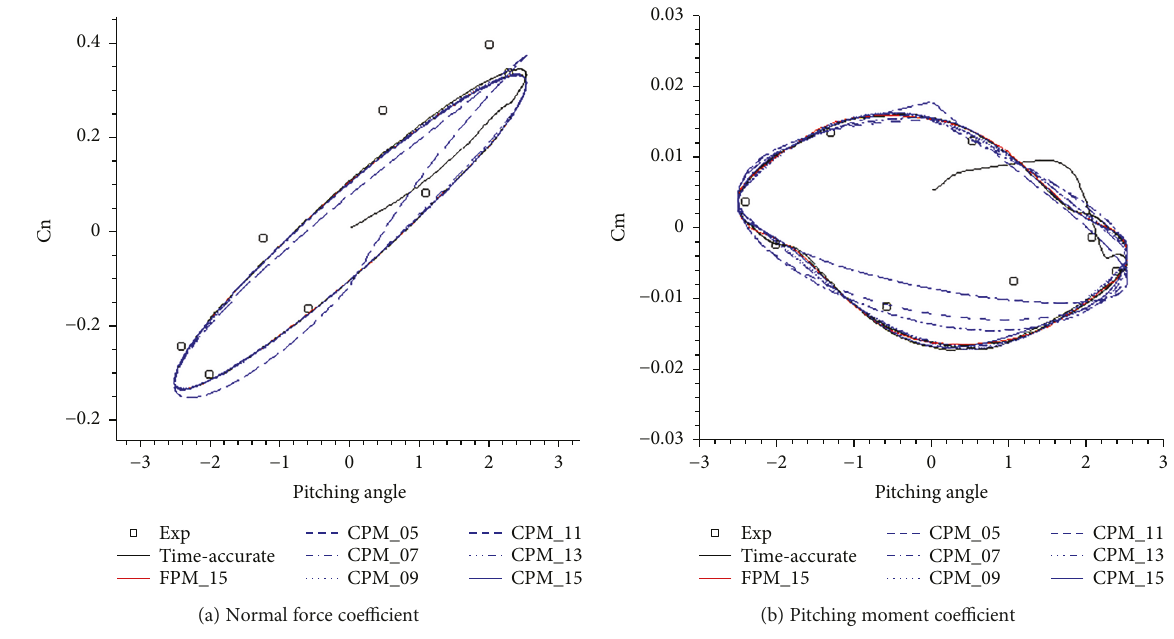
Figure 4: Normal force and pitching moment hysteresis of NACA 0012. Table 1: Dynamic derivatives for NACA 0012 airfoil from normal force.